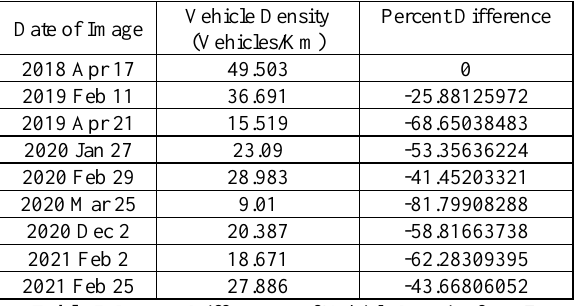
Table 5. Percent Differences of Vehicle Density from E. Rodriguez Ave.